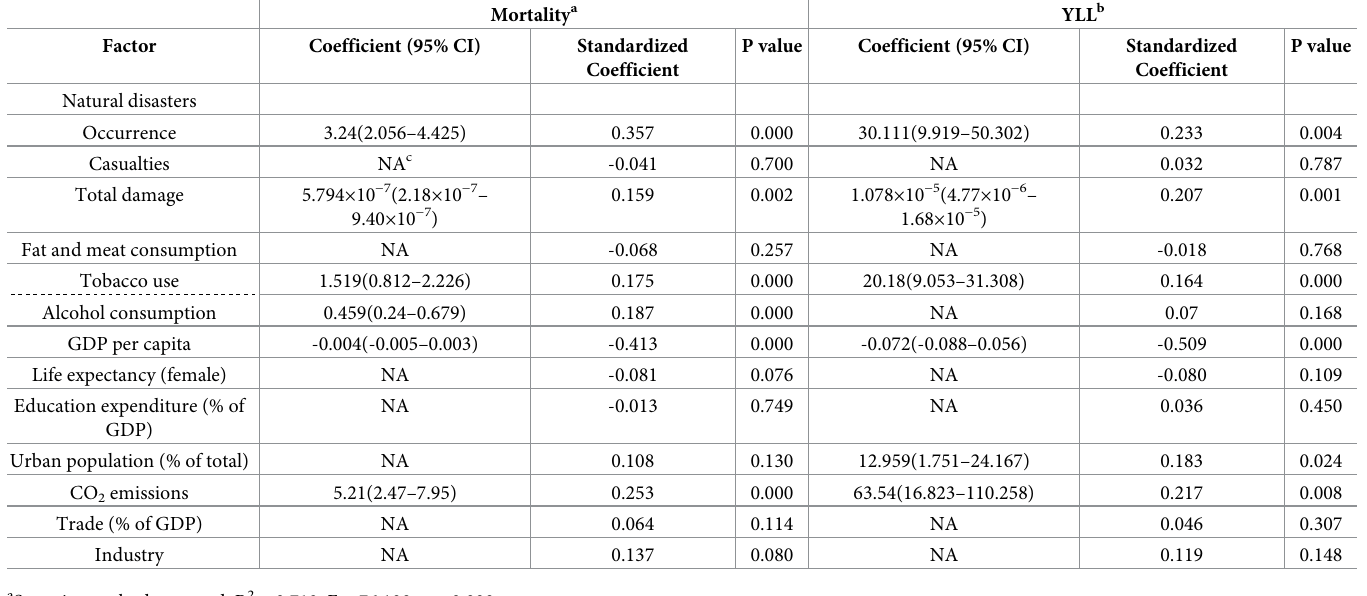
Table 4. Multivariate linear regression-derived coefficients of the associations of natural disasters and socioeconomic variables with IHD mortality and YLL rates among females from 1990 to 2017 in 193 countries, weighted by